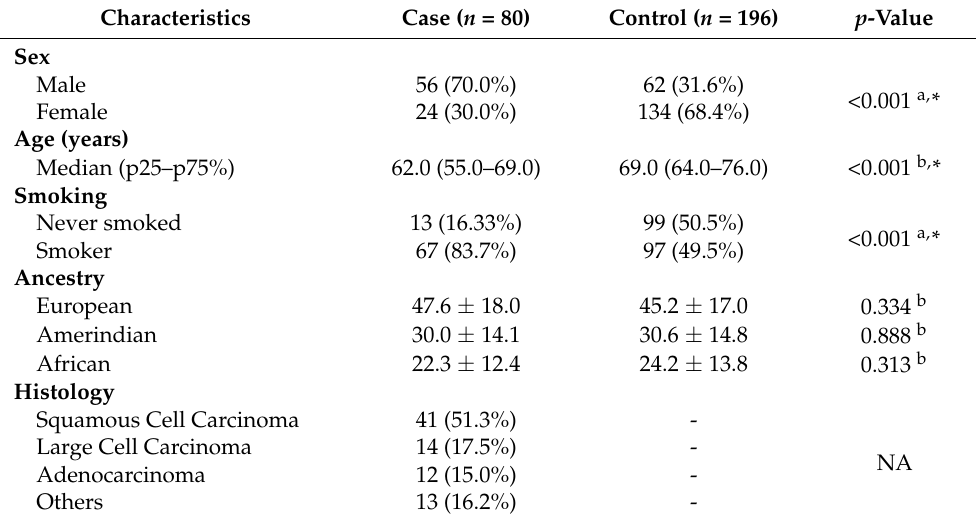
Table 1. Demographic and clinical characteristics of the investigated